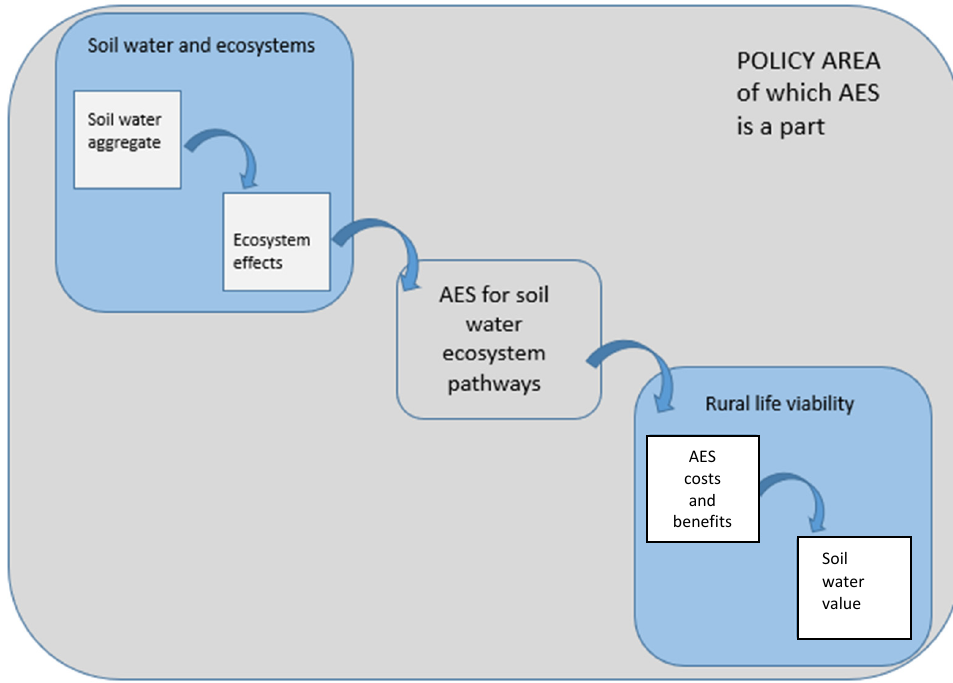
Figure 2. Policy area of which AES is a part.